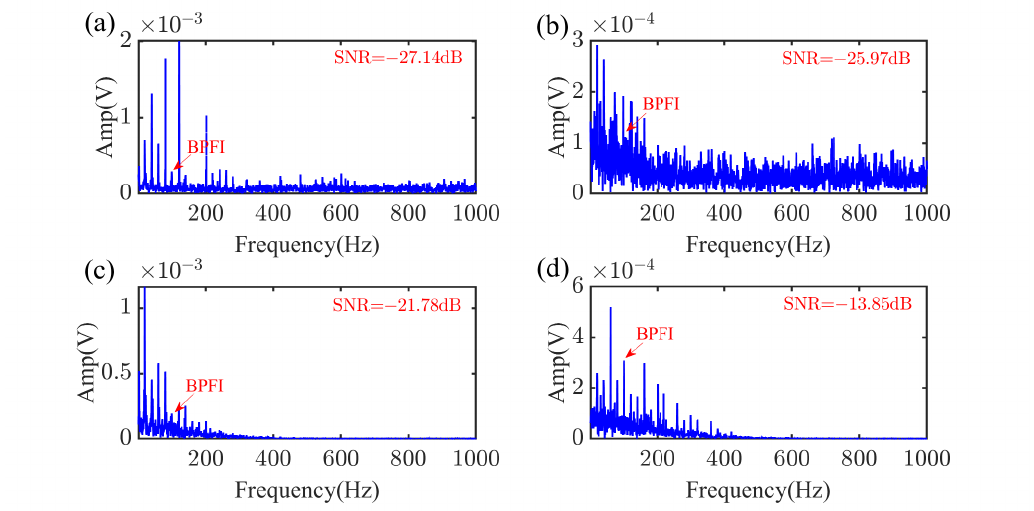
Figure 17. Envelope spectrum analysis results: ( a ) original signal; ( b ) band-pass filter; ( c ) VMD; ( d ) the proposed